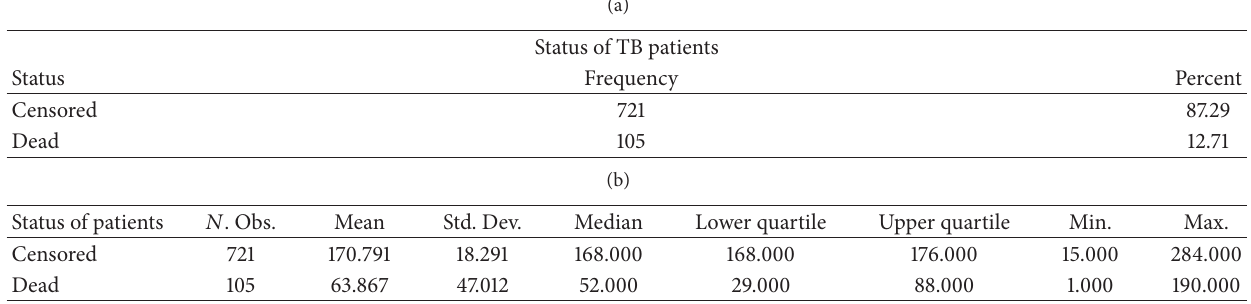
Table 2: Summary statistics of status of TB patients and days of follow-up time. (a)